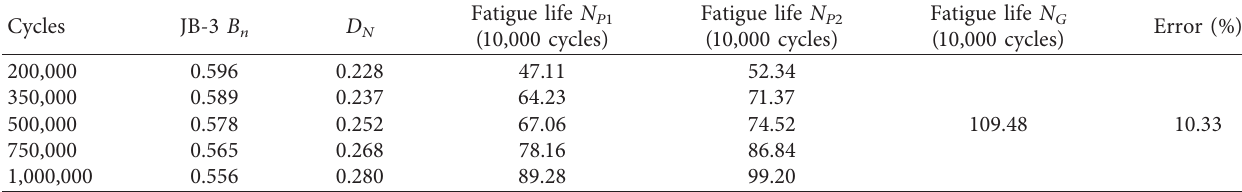
Table 5: Comparison between prediction values and test results for fatigue life based on the flexural rigidity of reinforced beam sections.